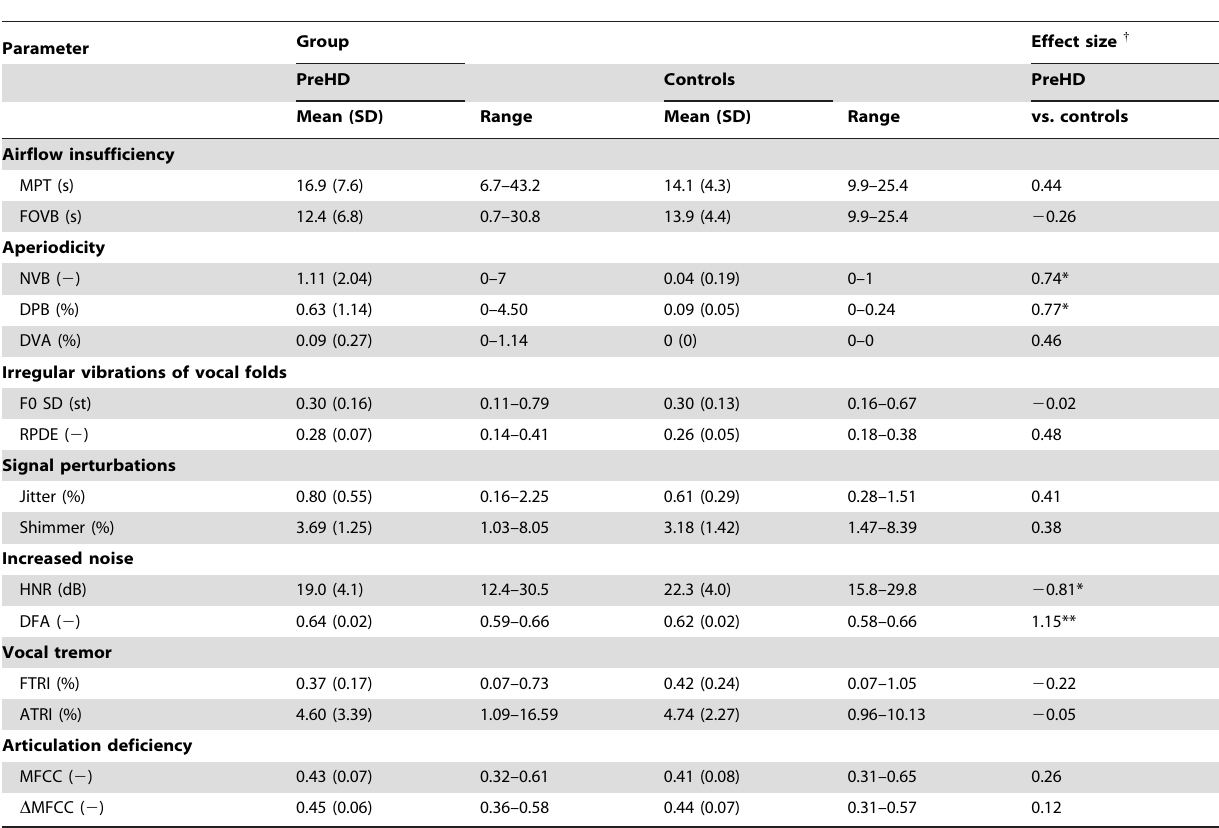
Table 3. Results of voice analyses in PreHD individuals and appropriate